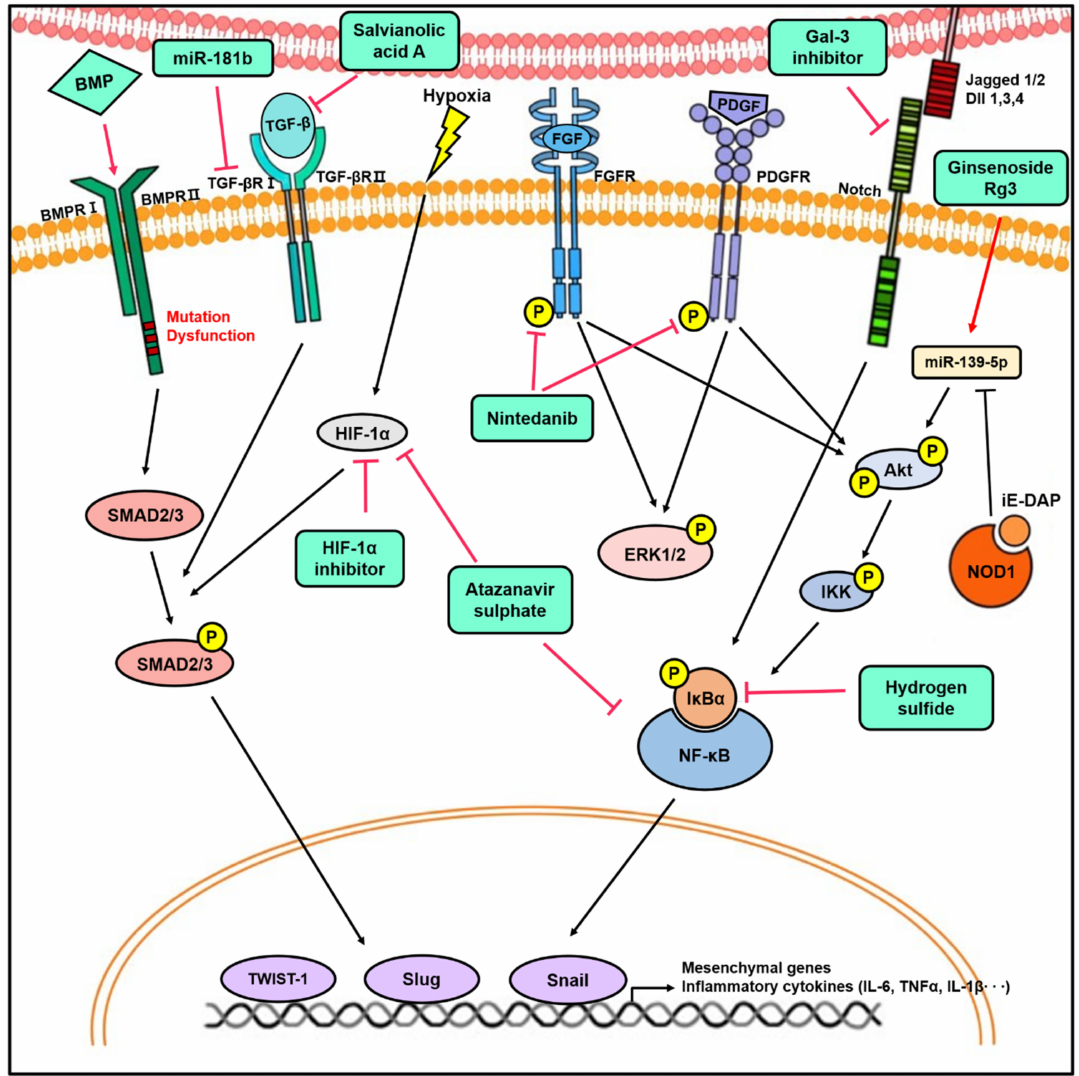
Figure 3. The novel therapeutic approach for lung diseases by targeting EndMT. The modulation of signaling pathways involved in EndMT by miRNAs, inhibitors, and agonists has therapeutic e ff ects in vitro and in vivo. Targeting EndMT reduces mesenchymal marker expression and pulmonary vascular remodeling, which ultimately ameliorates the hemodynamic phenotypes in the animal model of PH. In addition, the inhibition of EndMT decreases fibrotic lesion in various PF animal models. This provides insight into the therapeutic potential of targeting